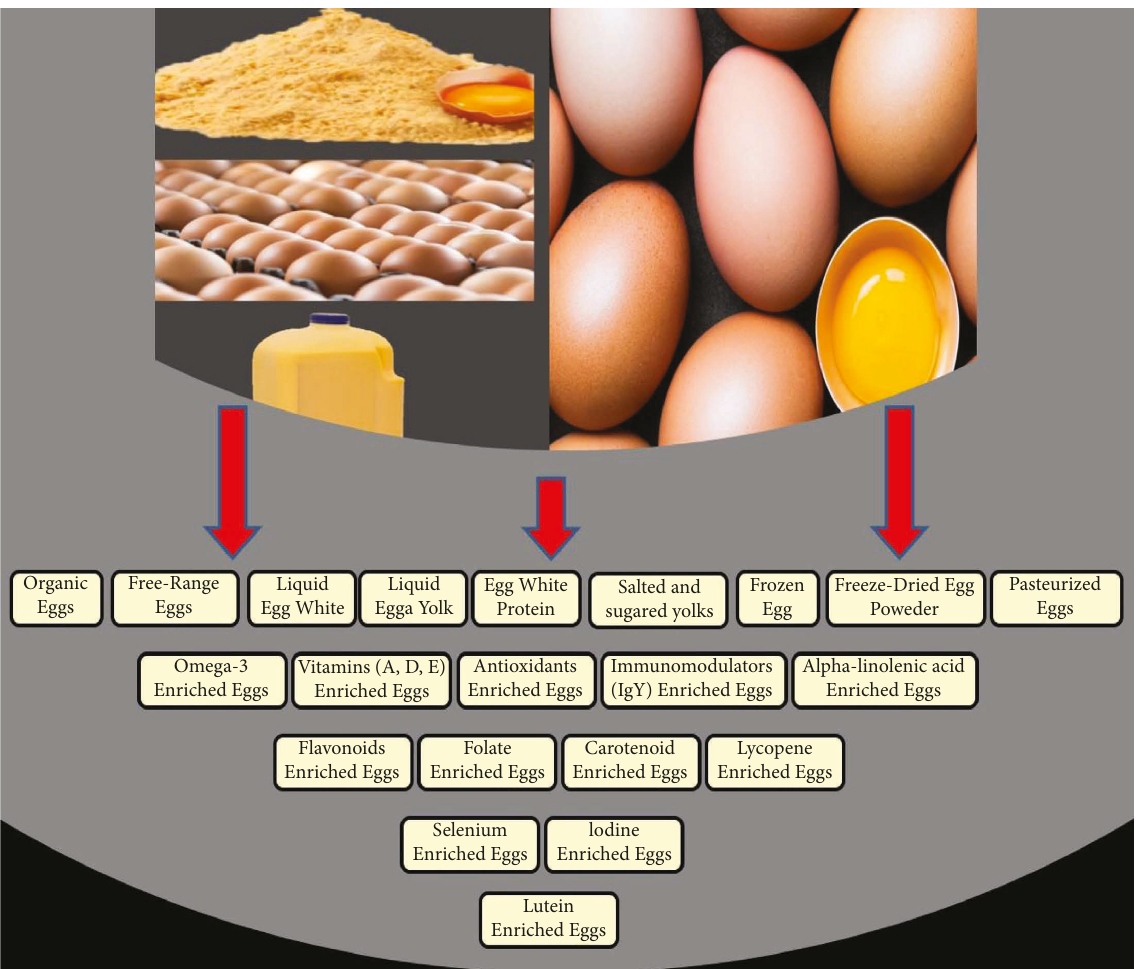
Figure 1: Unconventional and designer egg